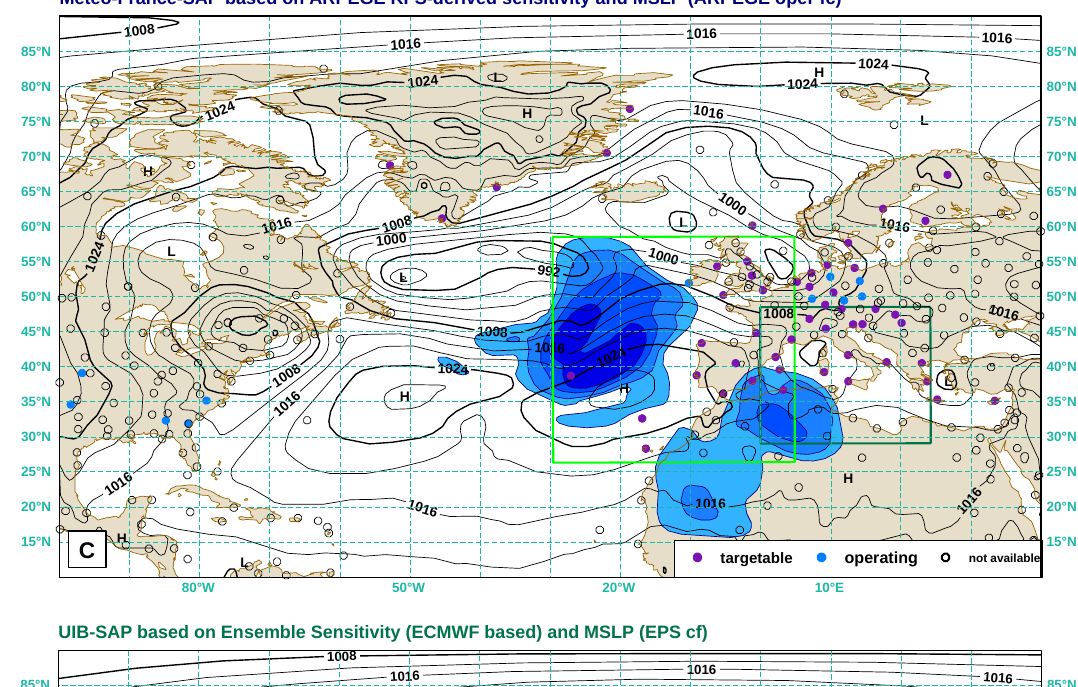
starting from the analysis of 3 December at 18:00 UTC (TT) and verifying on 5 December at 00:00 UTC